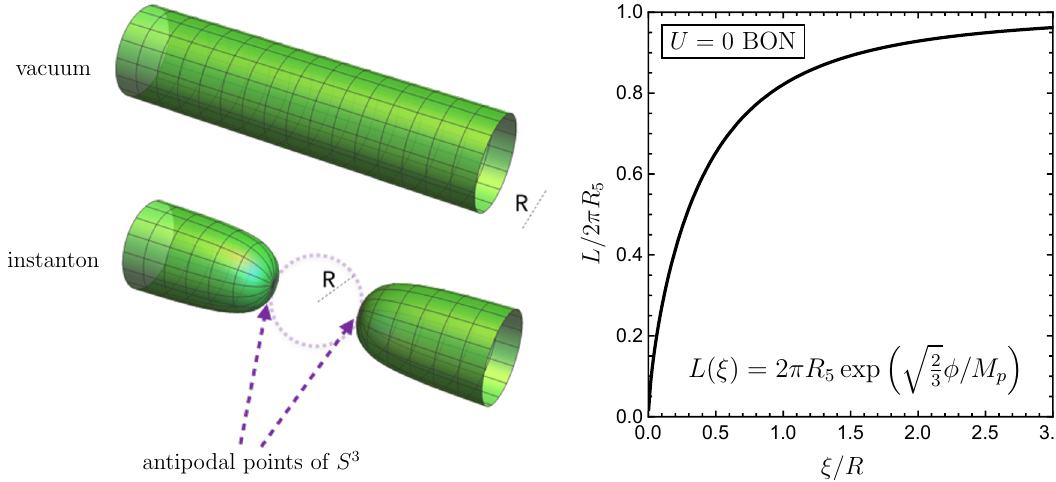
Figure 3: Diagram R5  ) Figure 2 . Left: diagram showing the geometry of the KK false vacuum (“vacuum”) and BON Figure 11: Just L (  (“instanton”) solutions. The r direction lies along the symmetry axis, with the periodic y coordinate along the azimuth. In the false vacuum, φ ≡ 0 , and the KK radius is independent of r . For Witten’s bubble, the KK radius approaches zero near r , whereas far away from the bubble wall & R 5